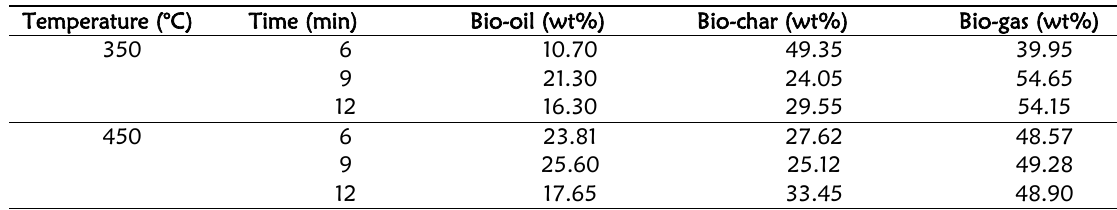
Table 1: Product yield of Palm Kernel Shells at different pyrolysis time and temperature using microwave-assisted hydrothermal liquefaction process.